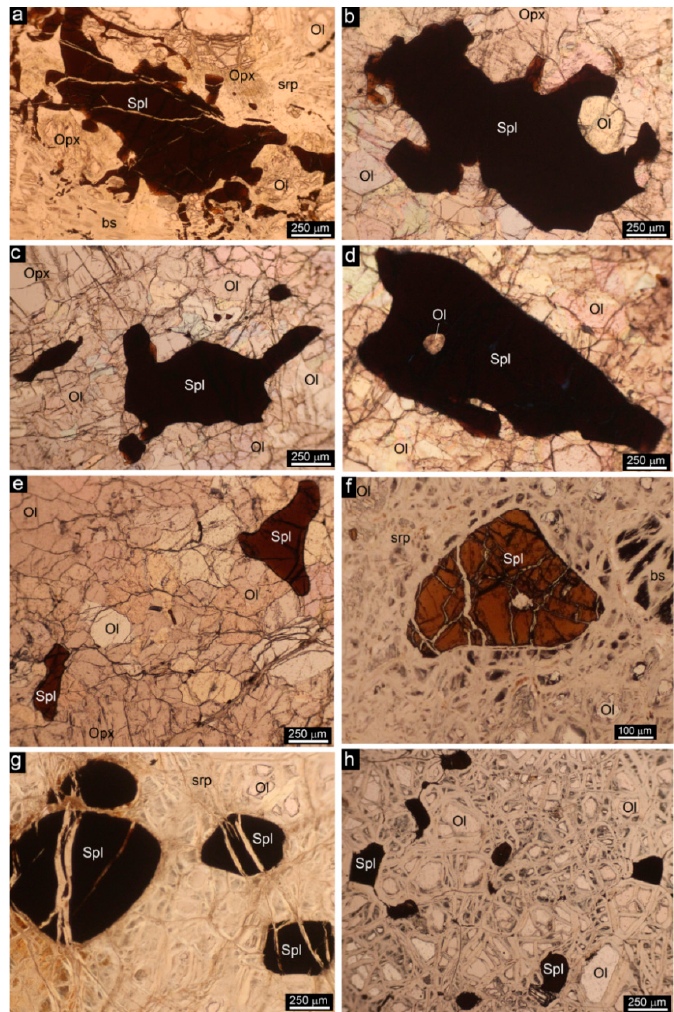
Figure 4. Morphological features of accessory spinel grains from ultramafic rocks of Kempirsay massif: ( a , b )—Anhedral Cr-spinel grains (holly leaf) with silicate inclusions, as well as units of ol-spl and opx-spl “symplectites” close to them ( a —sample 809/347, b —sample 8156); ( c )—Unequally-grained Cr-spinels in lherzolite: fine-grained euhedral and subhedral grains, and large anhedral grain with branches (sample 7087); ( d )—Large anhedral Cr-spinel grain containing inclusions and occupying silicate fragments in lherzolite (sample 7087); ( e )—Subhedral and elongated Cr-spinel grains in fresh spinel peridotite (sample 7087); ( f )—Subhedral Cr-spinel grain in serpentinized harzburgite (sample 012/300.9); ( g )—Isometric smooth Cr-spinel grains in dunitic serpentinite (sample 947/540); ( h )—Subhedral and euhedral Cr-spinel grains in serpentinized dunite (sample 046/359.5). bs—bastite, srp—serpentine. Chromitites show a further change in the morphology of Cr-spinel grains. Poorly disseminated chromitites are composed of small grains of chromite (0.1–0.5 mm) with